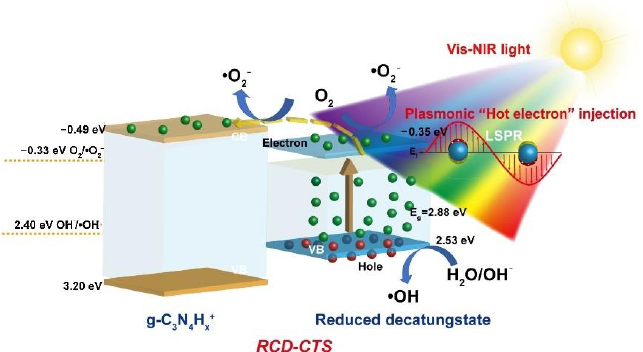
Figure 2. Mechanism of RCD-CTS photocatalyst under Vis-NIR light excitation [37]. Copyright, 2020 Elsevier Inc.